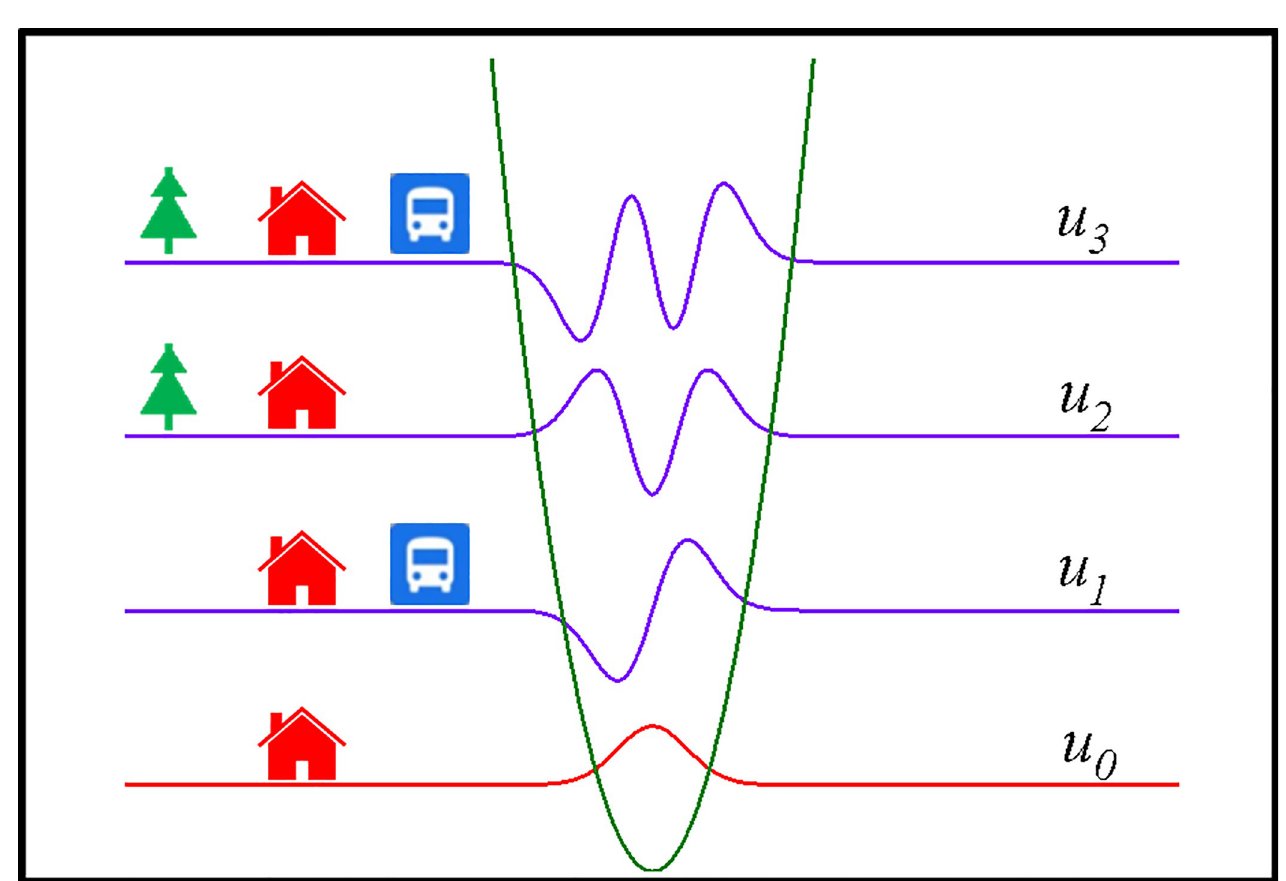
Fig 3. Schematic plot of HPW in the quantum mechanical harmonic